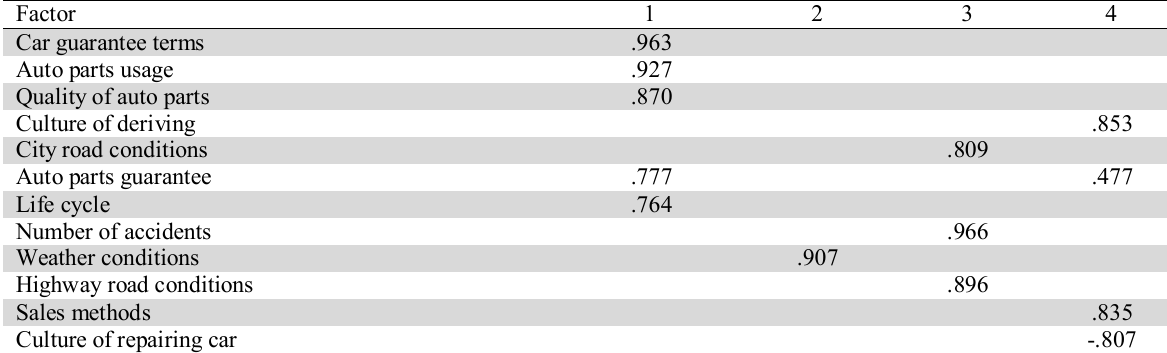
The results of factor